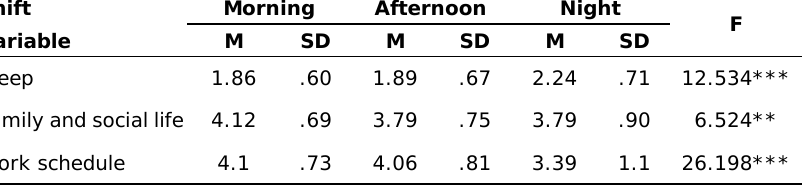
Table 2. Results of the comparison between shifts sleep, satisfaction with family and social life, and satisfaction with work schedule. Shift